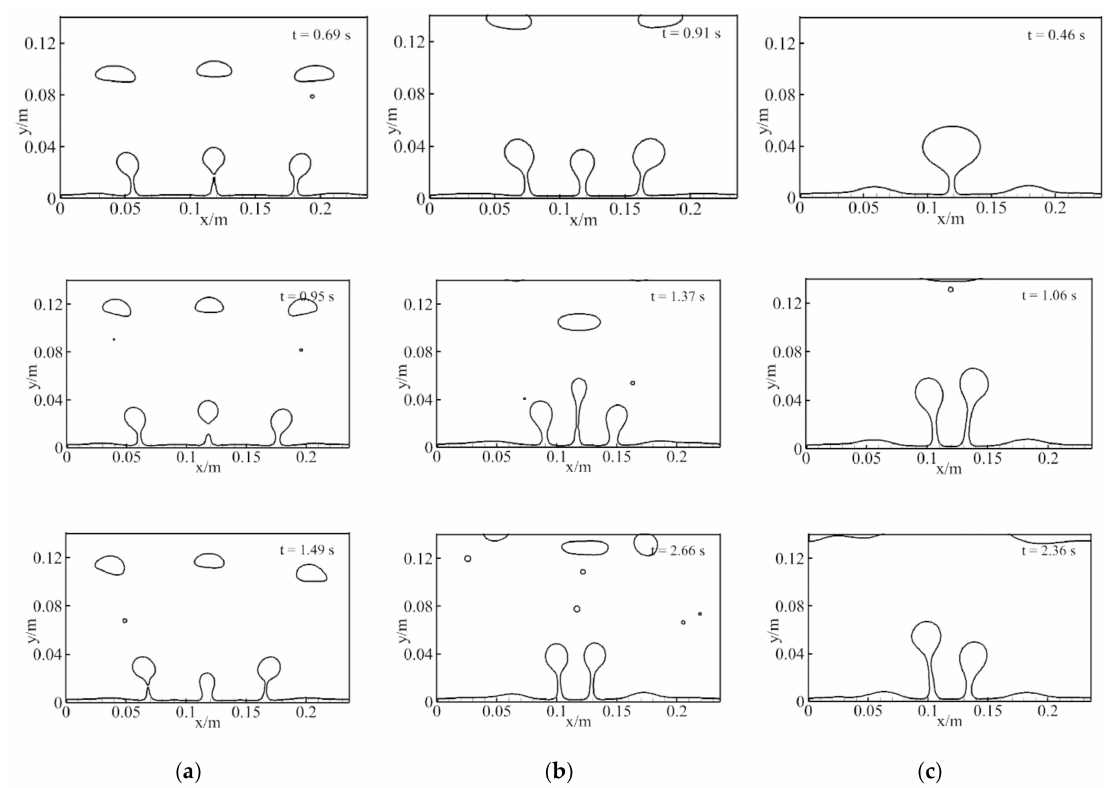
Figure 12. The bubble detachment at different gravity levels when H 0 = 15 kA/m. ( a ) g / g e = 1.0, ( b ) g / g e = 0.44, and ( c ) g / g e = 0.11.